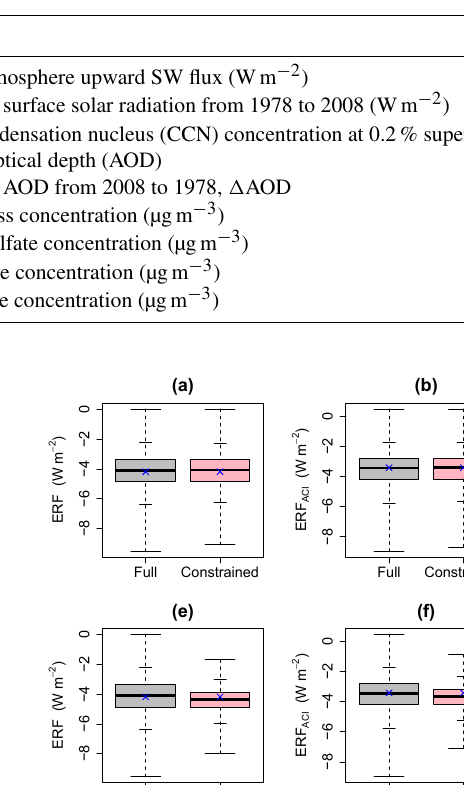
Table 5. Effect on the uncertainty in aerosol properties over Europe in July when the model is constrained by AOD (assumed measurement uncertainty range 0.14–0.19). The aerosol uncertainties are given as the 2.5th and 97.5th empirical percentiles of the PDF to form a 95% credible interval.